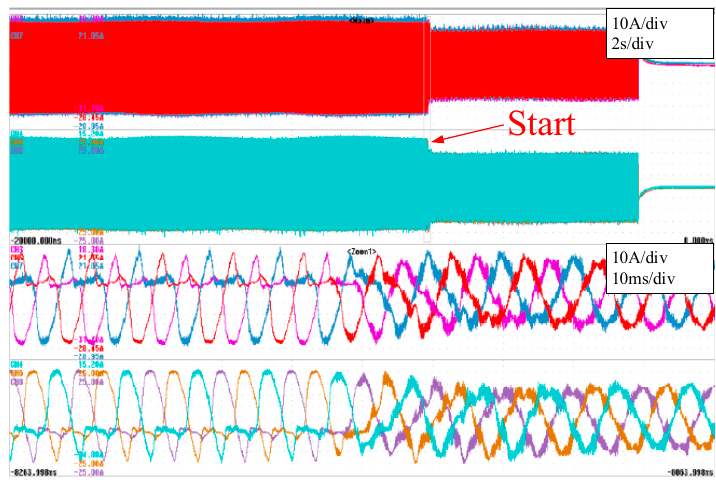
Figure 24. Arm currents with resonant controllers.